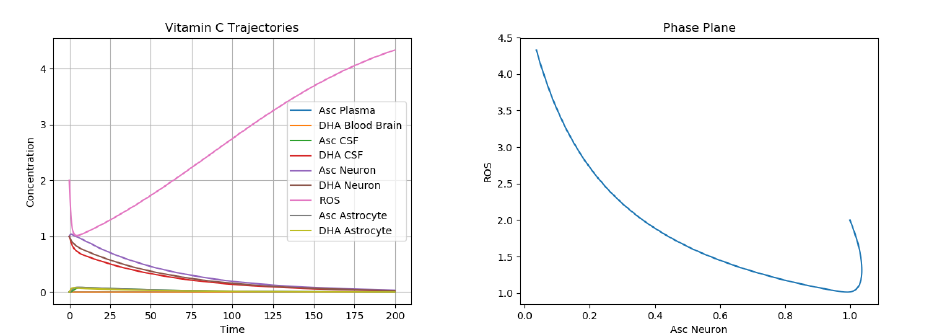
Figure 6. Dynamics of AA, DHA, and ROS during Stroke with not Enough